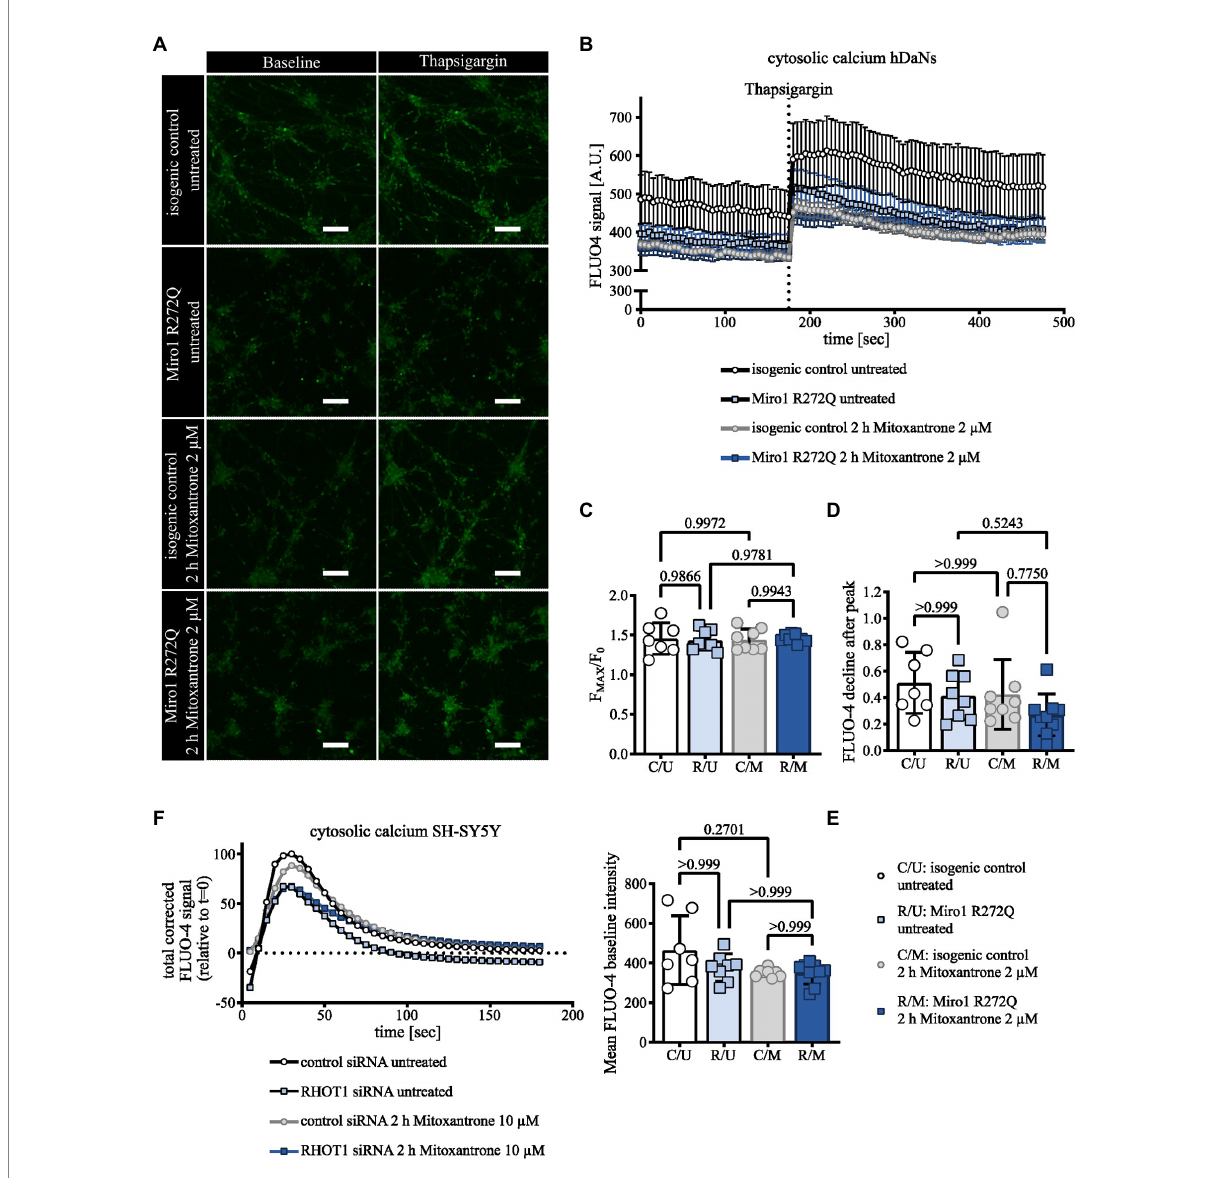
FIGURE 3 Miro1 R272Q alters calcium dynamics. (A) Representative Images of hDaNs before and after stimulation with 5 μ M Thapsigargin. hDaNs were pretreated for 2 h with 2 μ M Mitoxantrone and stained with cytosolic calcium indicator FLUO-4. (B) Cytosolic calcium trace in hDaNs before and after stimulation with 5 μ M Thapsigargin. Quantification of total FLUO-4 signal. n = 7–9 (each n corresponds to 1 culture dish) obtained from 3 independent differentiations (n Diff = 3), data displayed as mean ± SEM. (C) Quantification (from Figure 3B) of F MAX /F 0 , (D) reduction rate of